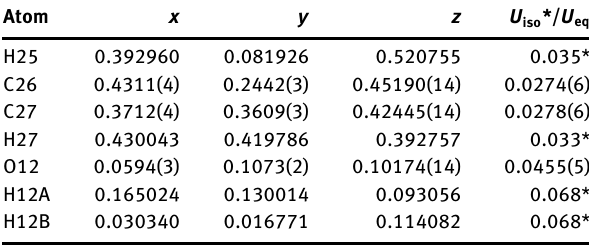
Table 2: Fractional atomic coordinates and isotropic or equivalent isotropic displacement parameters (Å 2